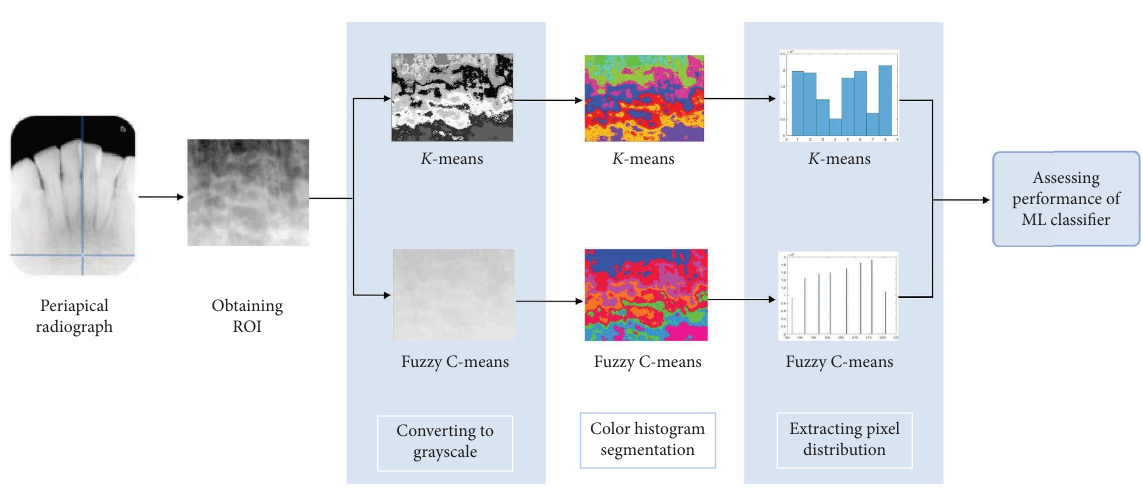
Figure 1: Te proposed method for automatic segmentation to detect osteoporosis on periapical